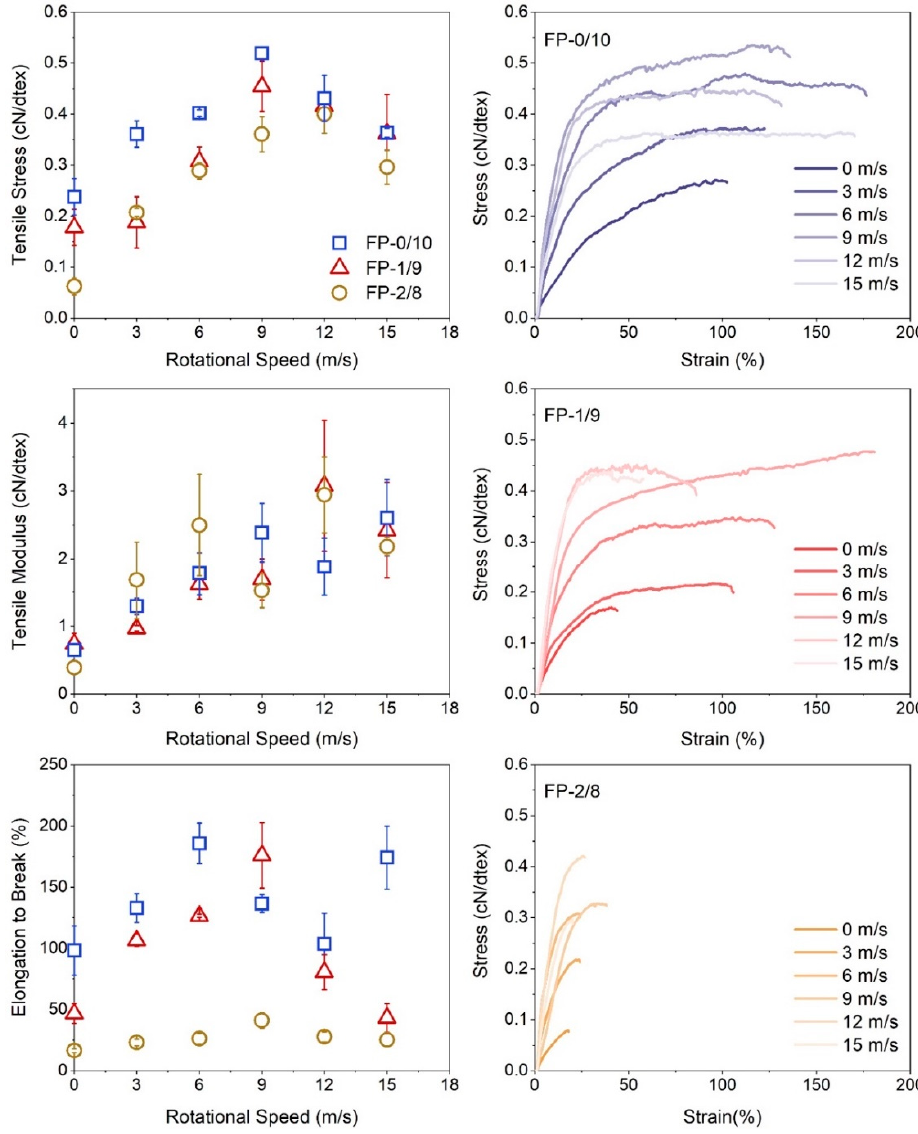
Figure 3. Tensile properties of the fabrics of FP-0/10, FP-1/9, and FP-2/10.